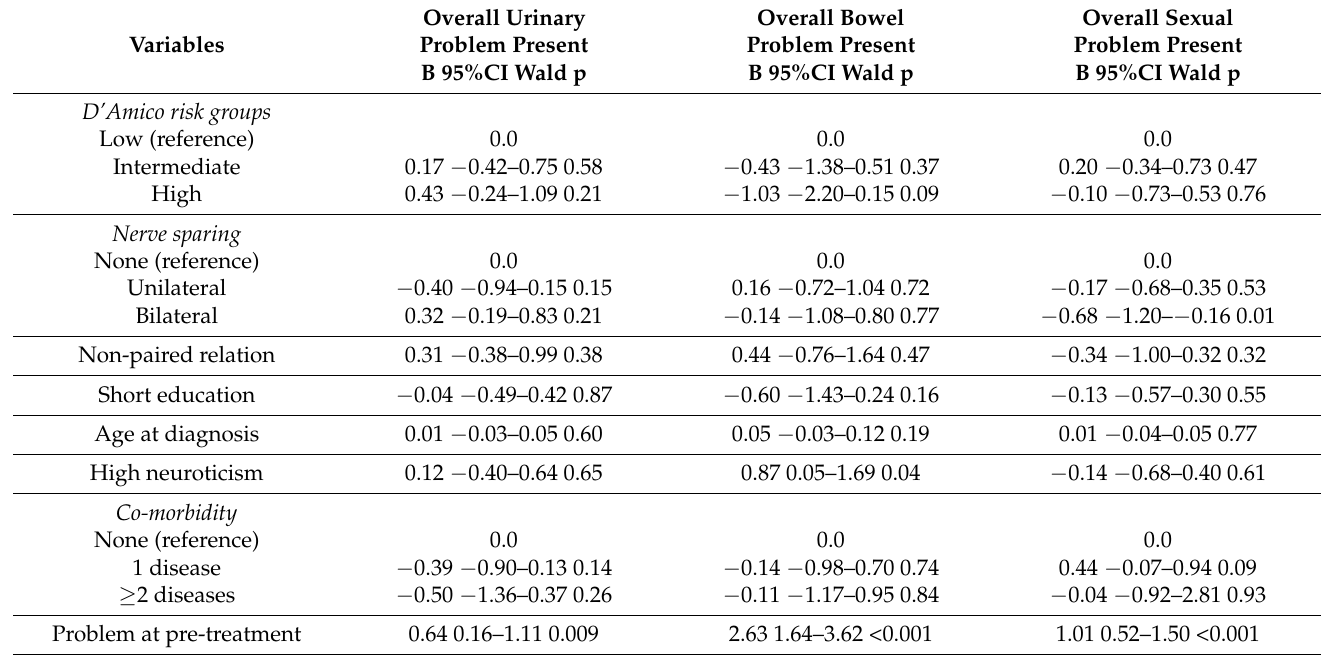
Table 3. General estimating equations (GEEs) estimates of predictors of overall problem present at 3-year follow-up.